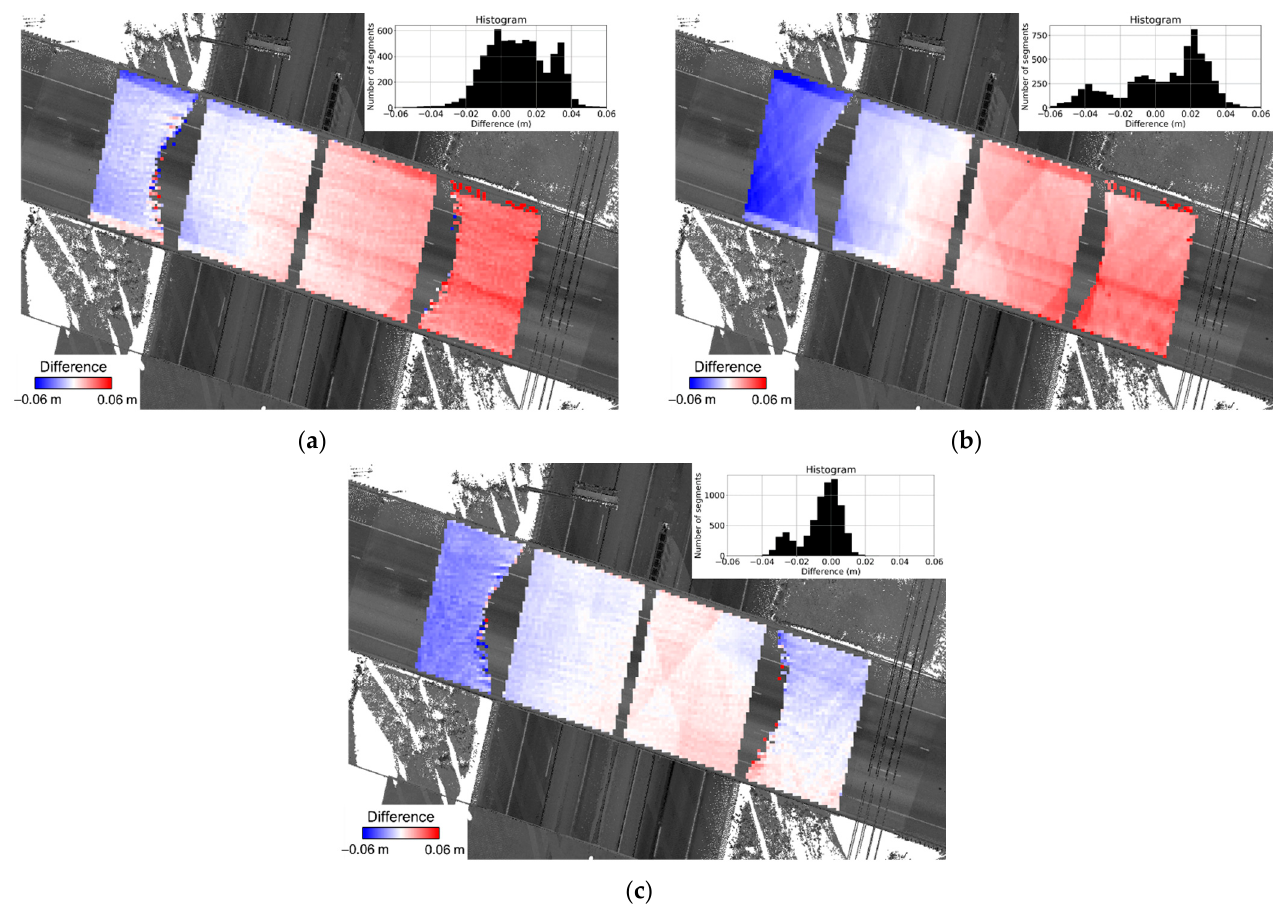
Figure 19. Heat map visualization of the difference in bridge deck thickness estimates between ( a ) TLS and PWMMS-HA, ( b ) TLS and PWMMS-UHA, and ( c ) PWMMS-HA and PWMMS-UHA. Table 4. Statistics of the difference between bridge deck thickness estimates from different systems.